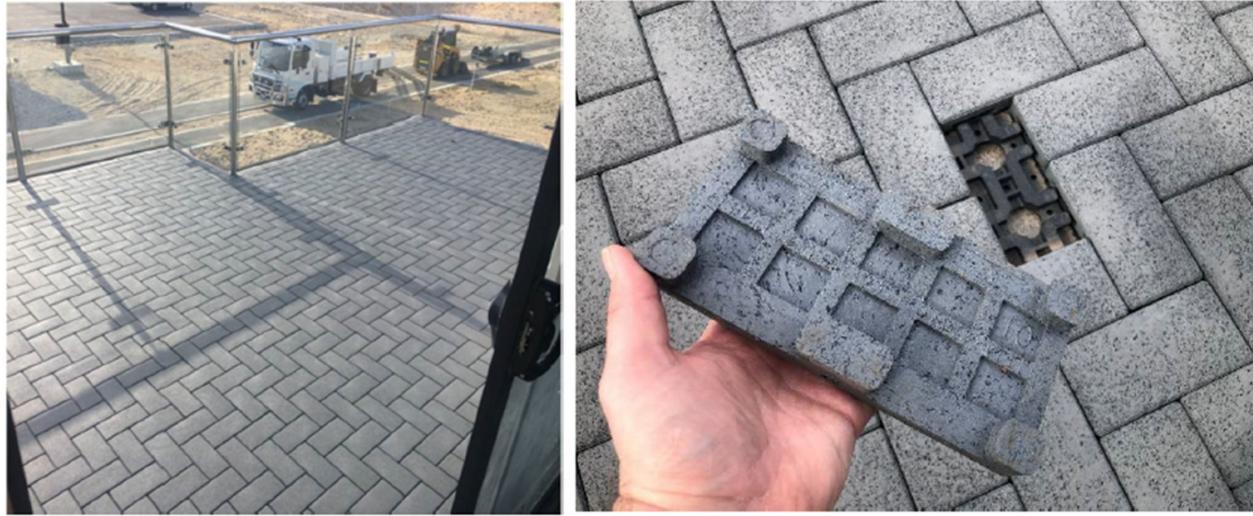
Figure 7. Balcony tiles made from recycled rubber and plastic